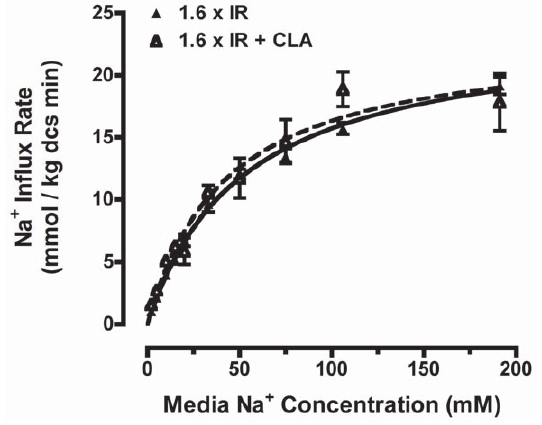
Figure 2. Na + transport kinetics of NHE1 in hyperosmotic medium. Michaelis-Menten Na + transport kinetics were determined for NHE1 in at RBCs following complete activation in hyperosmotic (1.6 6 IR) media, with (closed triangles) or without (open triangles) 500 nM CLA (data are compiled from n $ 3 independent experiments; means 6 SE). The data are fit by regression to a simple hyperbola, and the corresponding kinetic constants are reported in Table 1. The Na + transport kinetics (activity) are virtually identical in the two conditions.